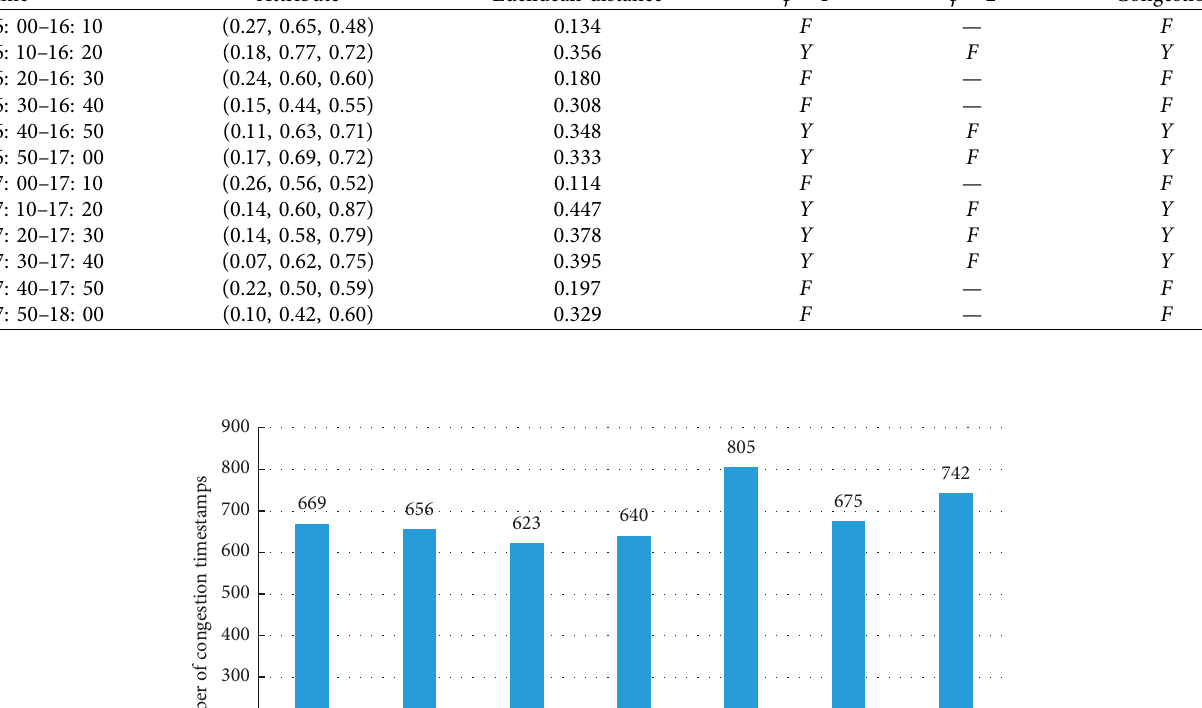
Table 6: An example of the calculation result (satisfies equations (4), (7), (8), and (10)) of traffic status discrimination in grid (3, 2). Time